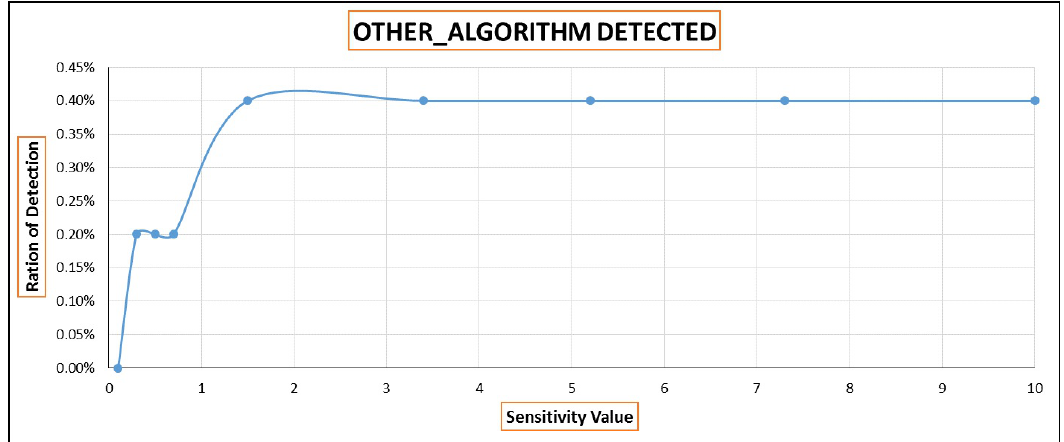
Figure 3. Changes in other algorithms detected with different sensitivities.